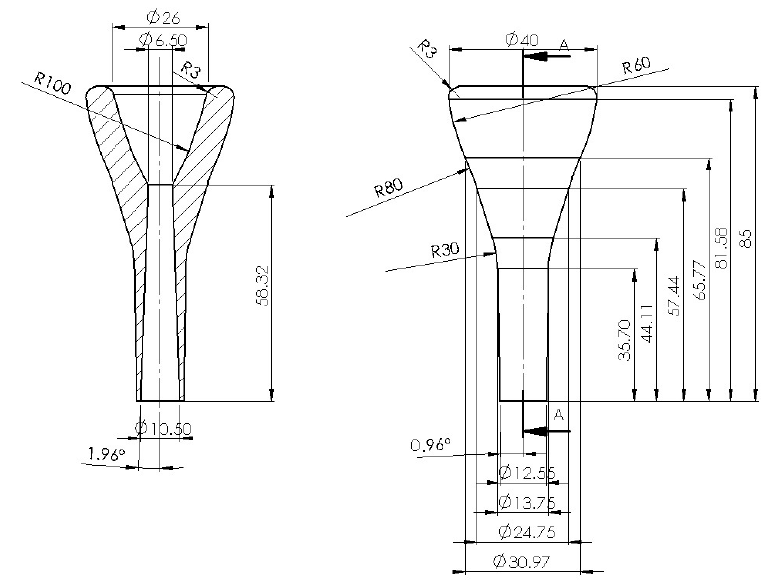
Figure 2. Dimensions of the designed mouthpiece.